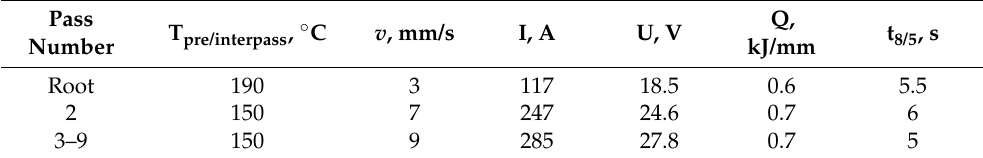
Table 6. GMAW welding